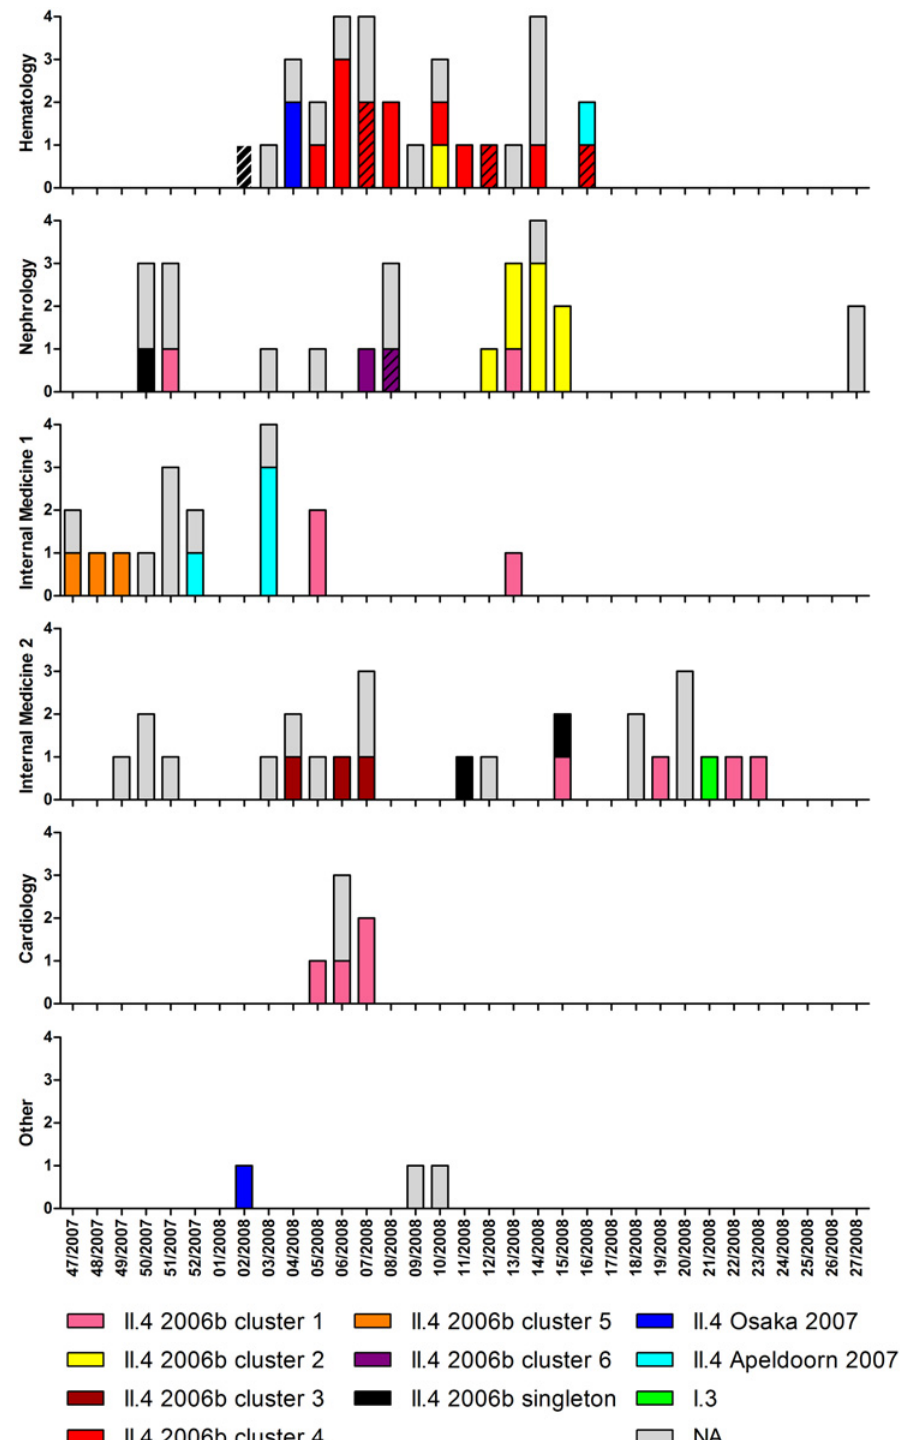
Figure 3. Local and temporal distribution of genotypes, variants and GII.4 2006b clusters. The first sample per inpatient is shown (n = 105). Units on vertical axes represent numbers of patients. NA (n = 49): no sequence information available (n = 29: sample not stored, n = 20: GII.4 specific PCR negative). The sequences from the first samples from six patients with persistent diarrhea are marked with diagonal shading.